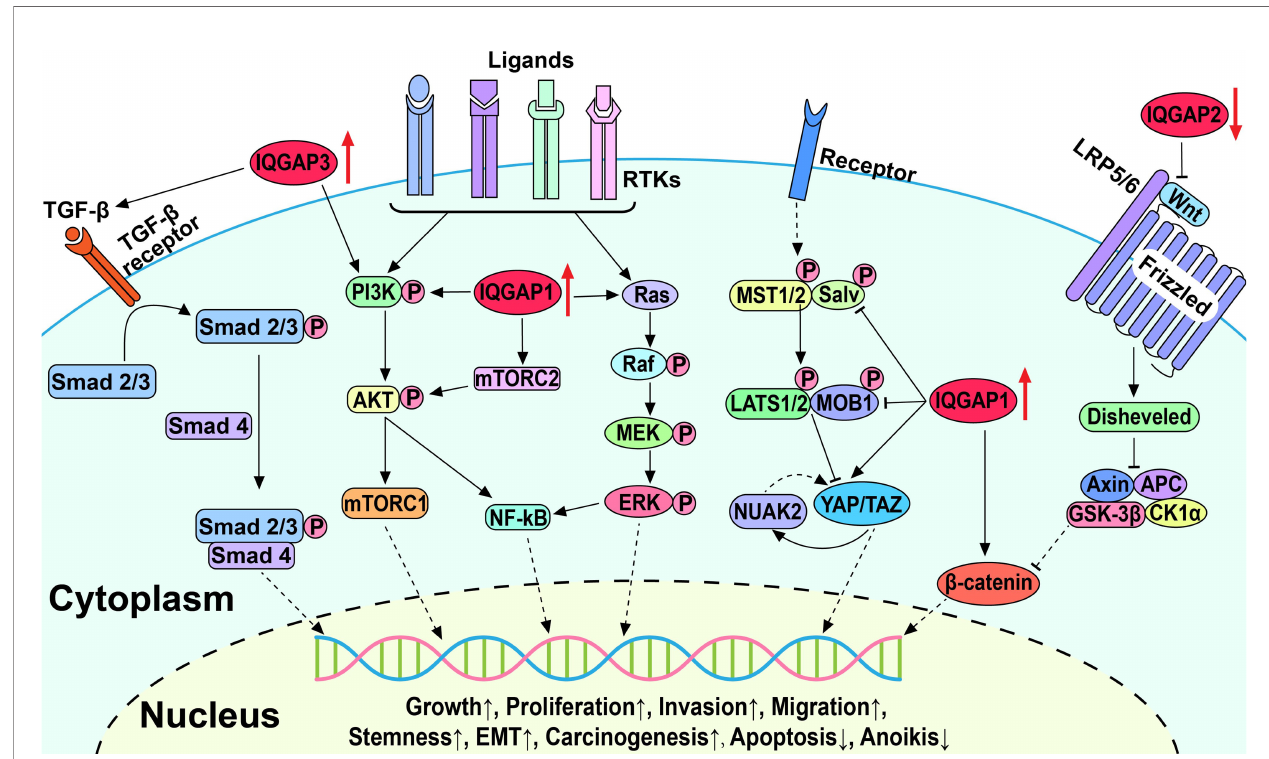
FIGURE 2 | Schematic diagram of IQGAPs-mediated signaling pathways involved in the pathogenesis of hepatocellular